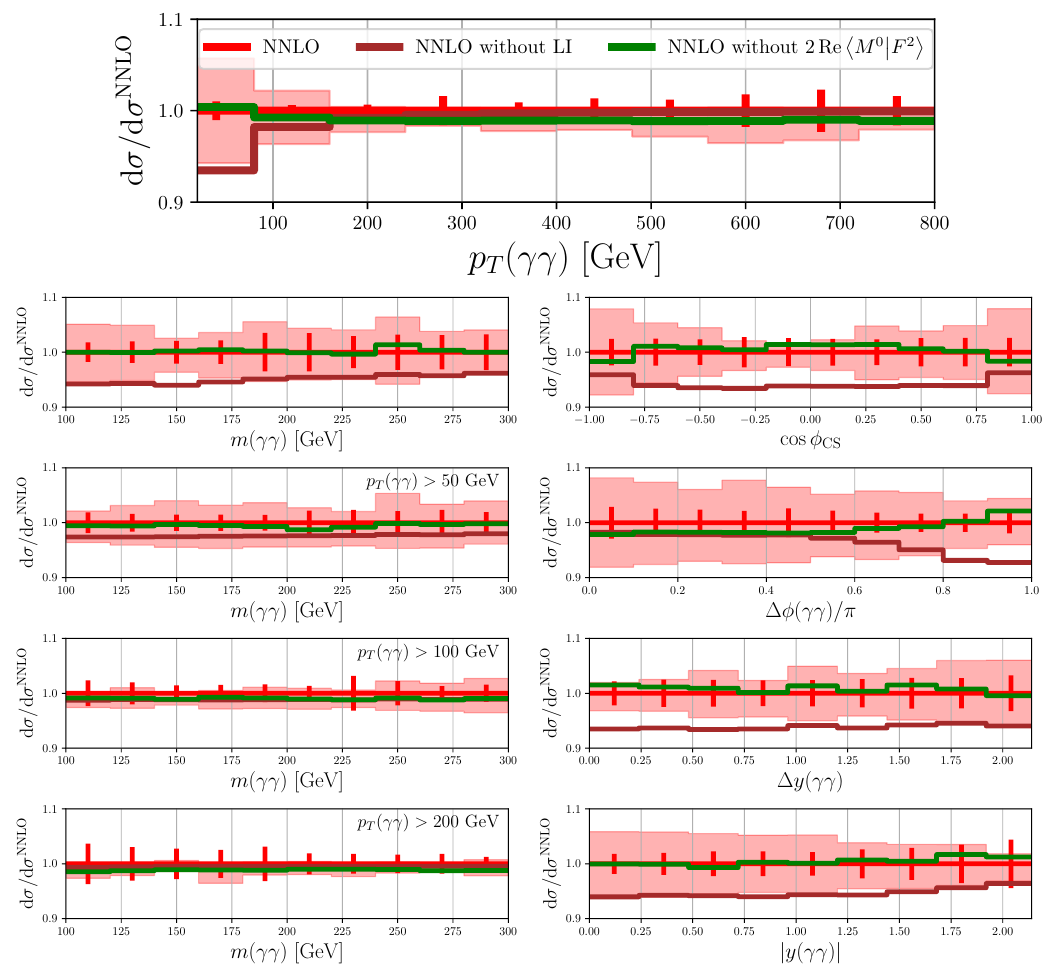
Figure 6 . Comparison of various approximations to the NNLO differential predictions: the com- plete NNLO prediction (red), NNLO excluding the loop-induced contribution (dark brown) and NNLO excluding the finite remainder H (2) ( s ) defined in eq. (2.1) (green). The colored bars 12 shows the MC integration error of the complete NNLO prediction while the red band shows its scale